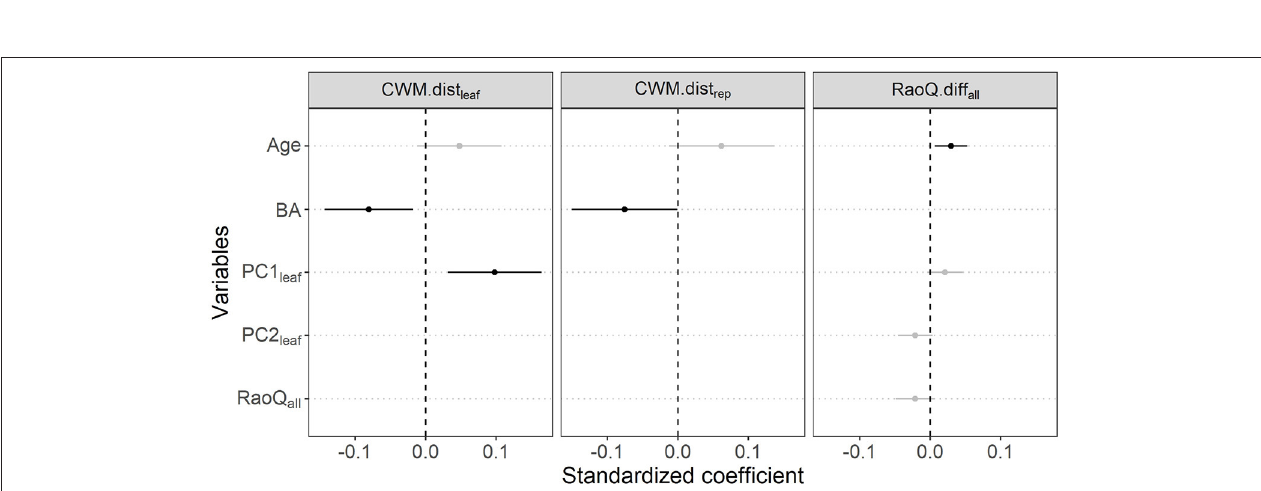
FIGURE 2 | Ordination diagrams of Principal Component Analysis (PCA) for community-weighted means of leaf (A) and reproductive (B) traits of canopy trees in secondary forests of southern Brazilian Atlantic Forest. Successional secondary forest sites are Encantada, Forqueta1, Forqueta2, and ProMata (green-blue colors), while restoration sites are Cachoeirinha, Canela, and StTereza (warm colors). Circle sizes indicate an increase in the regeneration age of each forest stand. LA, leaf area; SLA, specific leaf area; LDMC, leaf dry matter content; LNC, leaf nitrogen content; LNC:LPC, leaf nitrogen-phosphorus ratio; SM, seed mass; FS, fruit size (sm: small; md: medium; lg: large); WD, wood density. The axes PC1 and PC2 of leaf traits, and PC2 of reproductive traits were considered as predictor variables of functional composition distance and diversity difference between the regeneration component of these secondary forests and their reference baseline (response variables: CWM.dist and RaoQ.diff in Figures 3 , 4 ).